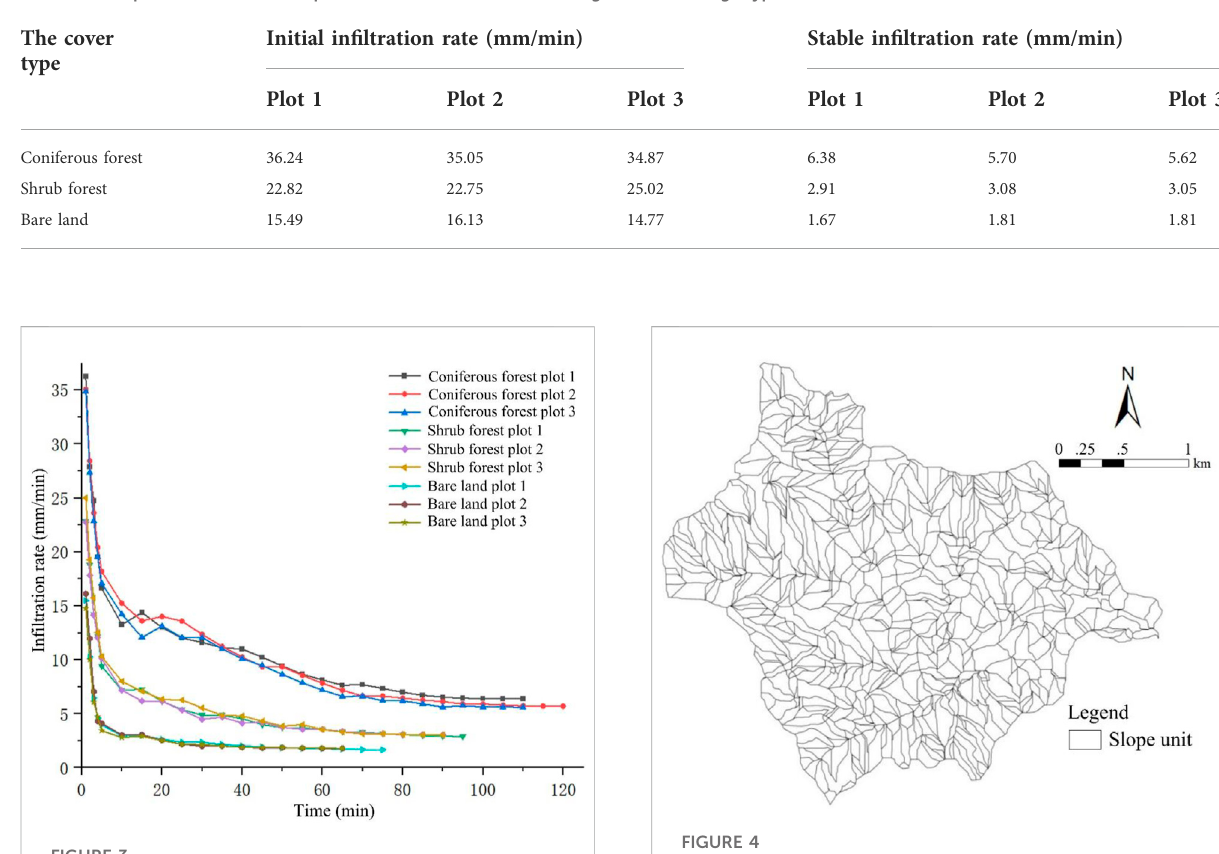
TABLE 2 Comparison of in fi ltration performance of three different vegetation coverage types.